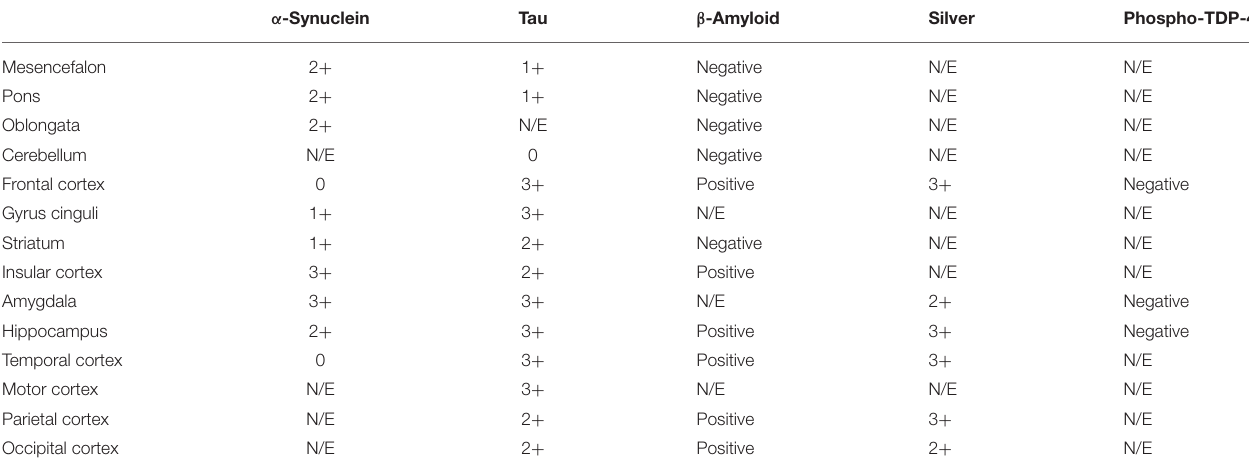
TABLE 1 | Results of the microscopic assessment. α -Synuclein Tau β -Amyloid Silver